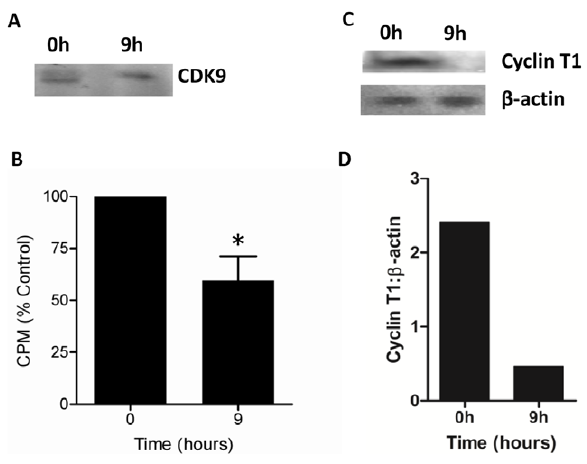
Figure 3. CDK9 activity and cyclin T1 expression decrease as neutrophils age in culture. Isolated human neutrophils were cultured for 9h and (a) CDK9 protein expression and (b) enzymatic activity were determined and compared with freshly isolated cells (0h). For CDK9 activity protein was immunoprecipitated from neutrophils with a monoclonal anti-CDK9 antibody and activity determined by incorporation of [ c 32 P]-ATP into the CTD of RNA polymerase II. The phosphorylated peptide was isolated on an SDS-PAGE gel and excised for scintillation counting. Data are expressed as % of the value for control freshly isolated cells and are mean 6 s.d. for three separate experiments. * indicates p , 0.05. (c). Isolated neutrophils were cultured for 0 h or 9 h and expression of cyclin T1 determined by western blotting. Blots were probed with an antibody to b -actin to confirm equal protein loading. The blot shown is representative of 4 separate experiments performed. (d) Western blots of CDK9 expression relative to b -actin were quantitated using